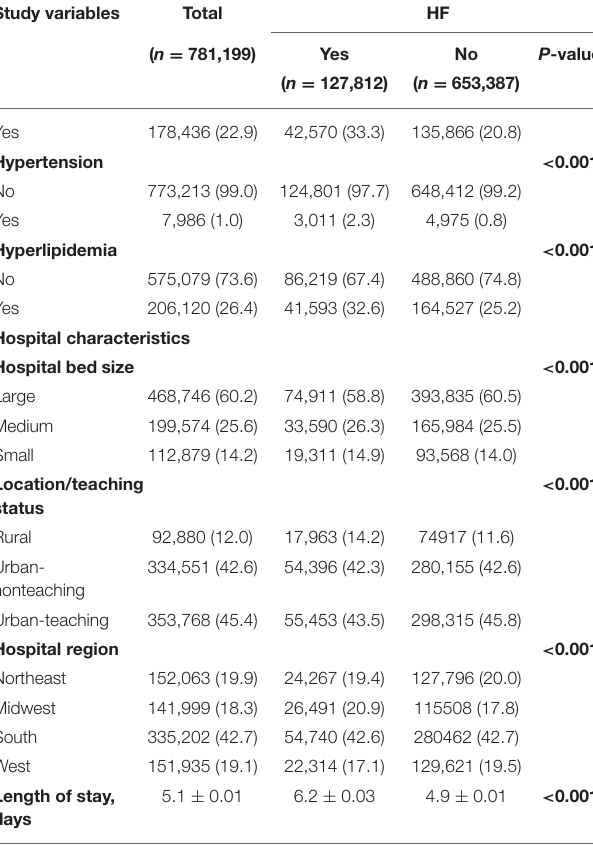
TABLE 1 | Characteristics of SLE/RA patients with or without